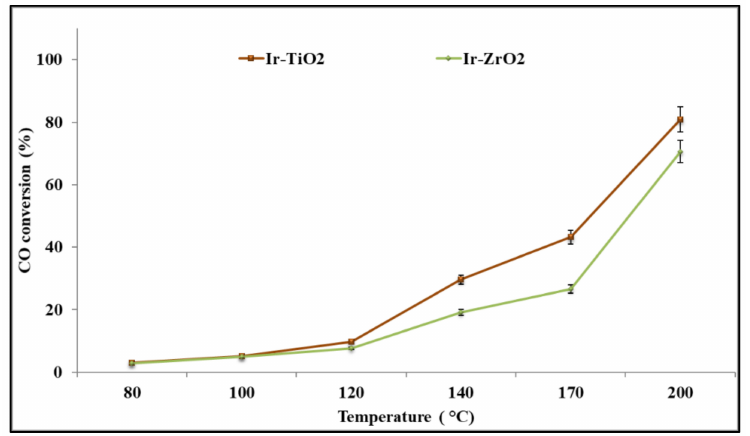
Figure 8. CO oxidation reactions over the catalysts with increasing temperatures (GHSV 12,000 h − 1 ).